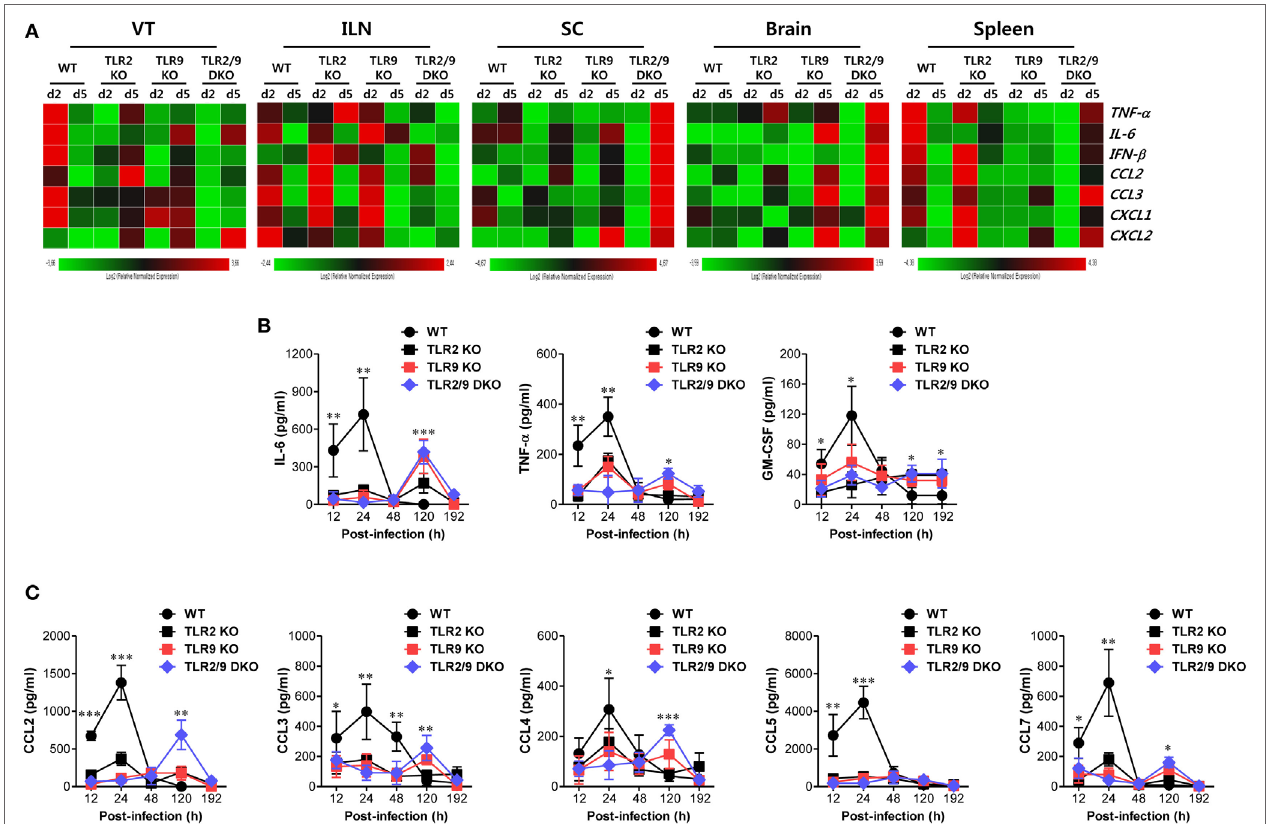
FigUre 5 | Both TLR2 and TLR9 are required for rapid responses of cytokine and chemokines in vaginal tracts (VTs) infected with herpes simplex virus type 1. (a) Heatmap showing the expression of cytokines and chemokines in each tissue. The expression levels of cytokines and chemokines were assessed by real-time qRT-PCR using total RNA extracted from the VT, iliac LNs, spinal cord, brain, and spleen of infected wild-type (WT), TLR2 KO, TLR9 KO, and TLR2/9 double knock-out (TLR2/9 DKO) at 0, 2, and 5 days post-infection (dpi). The expression of each cytokine and chemokine is normalized to the housekeeping gene β -actin and displayed as the average of relative fold expression compared with uninfected control group, according to the indicated color on a log 2 scale. (B,c) Secreted levels of cytokines and chemokines in vaginal lavages. Vaginal lavages were collected at the indicated dpi and used to measure levels of cytokines (B) and chemokines (c) by CBA. Data show the average ± SEM of values derived from at least three independent experiments ( n = 4–5). Two-way ANOVA followed by Bonferroni post hoc testing was conducted in (B,c) . * p < 0.05; ** p < 0.01; *** p < 0.001 comparing levels between WT and TLR2/9 DKO mice at the indicated time